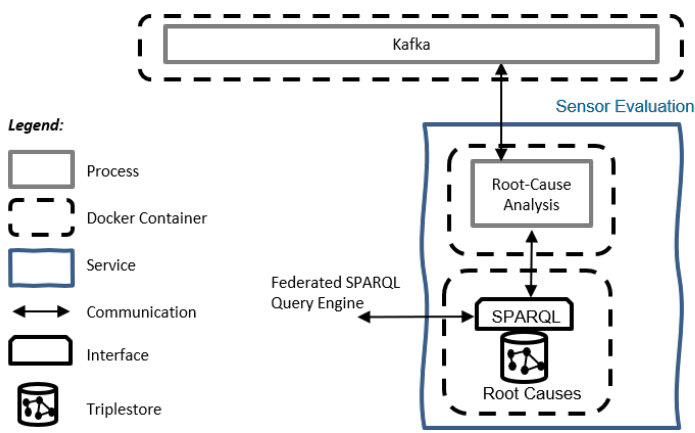
Figure 8. Smart Data Service and Communication Infrastructure.